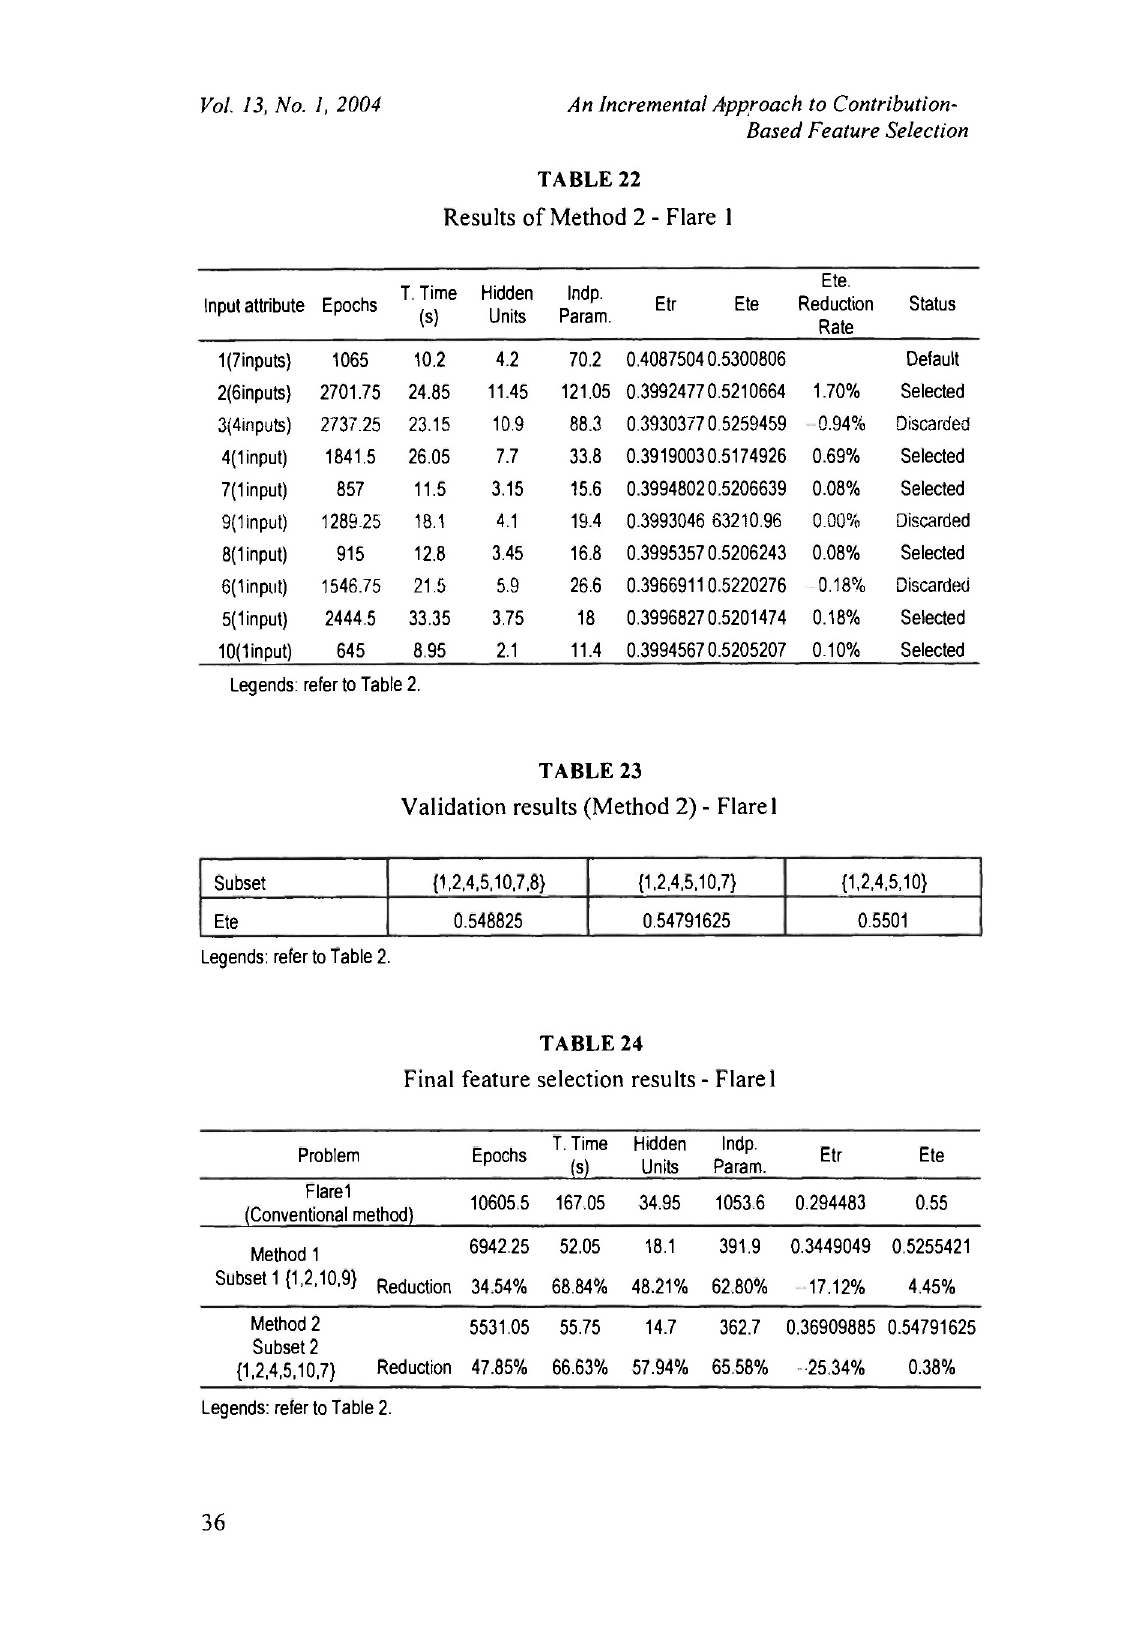
Validation results (Method 2) - Flare 1